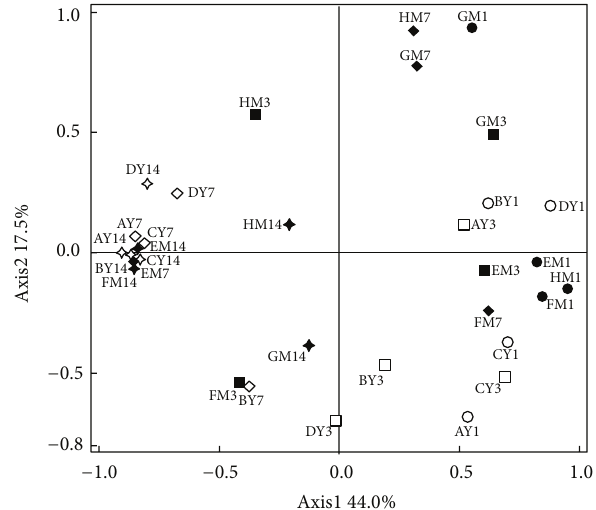
Figure 3: Principal coordinates analysis of weighted UniFrac values in the fecal methanogens of Meishan and Yorkshire piglets. Sample identifiers are the same as in Figures 1 and